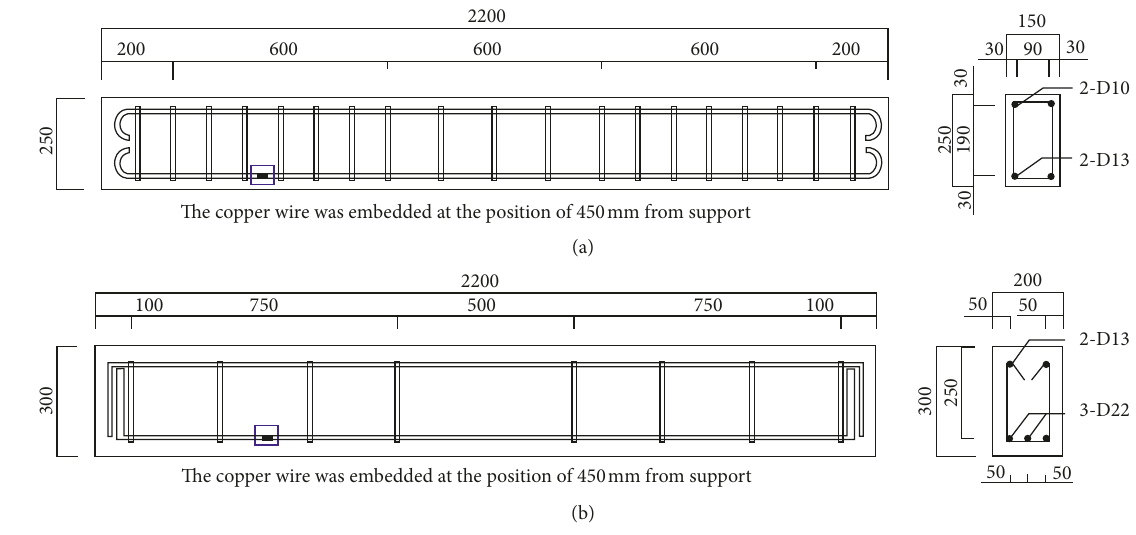
Figure 4: Reinforcement details of beams: (a) flexural failure type beam and (b) shear failure type beam.